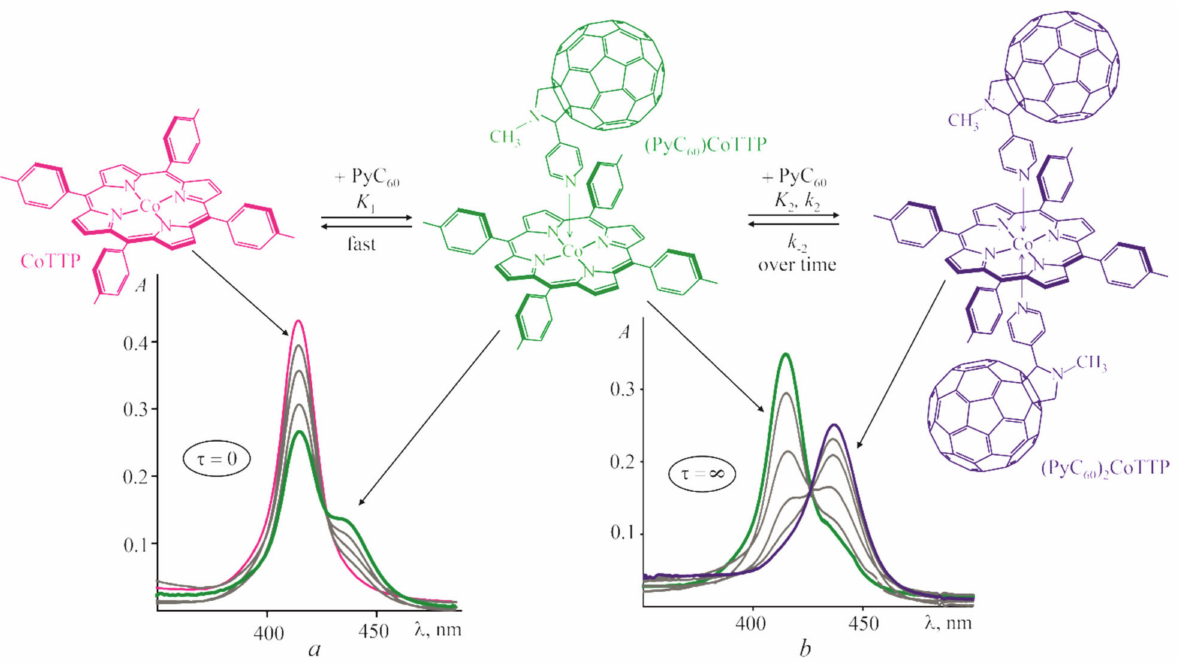
Figure 1. The scheme of the (PyC 60 ) 2 CoTTP formation and UV–vis spectrum transformations during the titration of CoTTP with PyC 60 (C PyC60 = 0 ÷ 7.7 × 10 − 5 M) in toluene immediately after mixing the reactants ( a ) and at the end of the reactions ( b